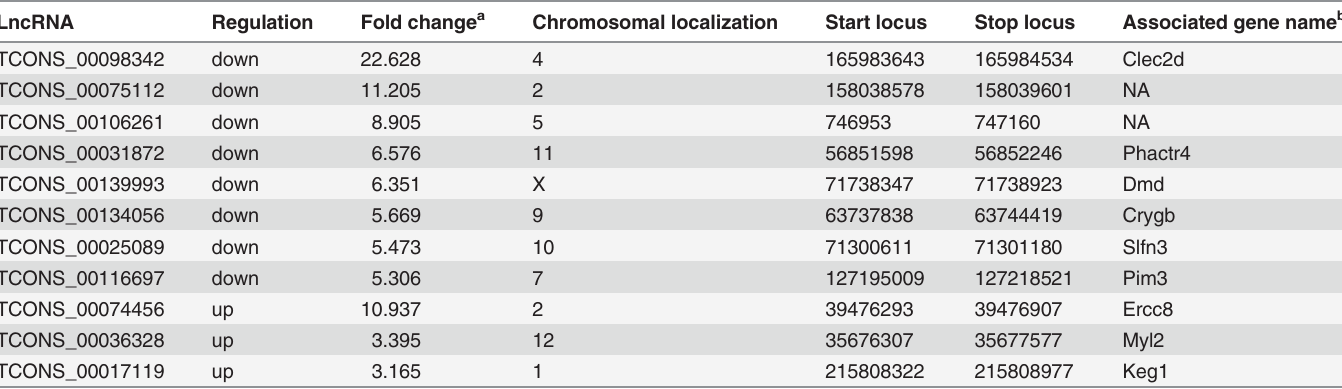
Table 4. The most down/up-regulated lncRNAs in the kidneys of low birth weight rats compared with normal controls (microarray data).